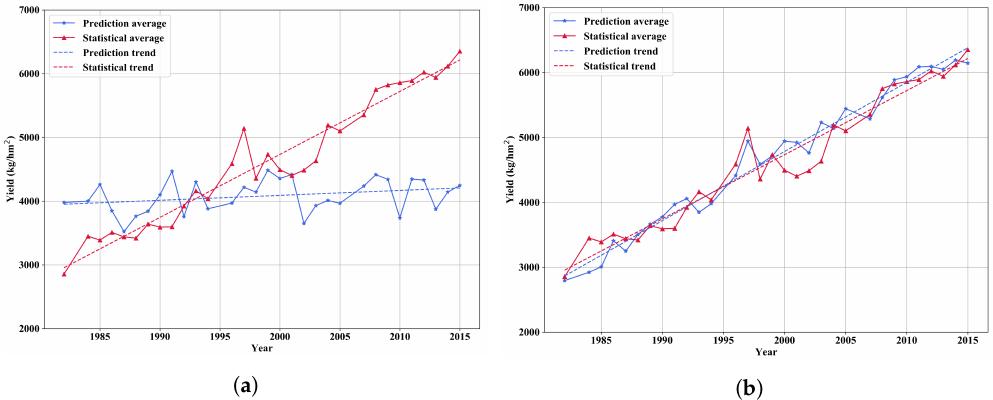
Figure 9. The predicted average yield of all counties before and after detrending. The red solid line is the average yield of all county-level yield data. ( a ) The predicted average yield of all counties before detrending; ( b ) The predicted average yield of all counties after